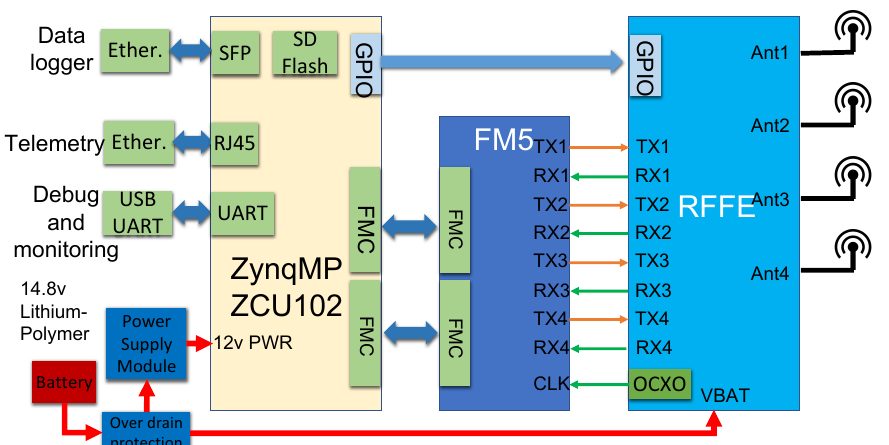
Figure 6. Block diagram of the hardware acrhitecture of the CHP2 prototype implementation. The system is driven by a ZynqMP ZCU102 evaluation kit, which interfaces with and ADI FMCOMMS5 RF evaluation board to produce RF signals, a transmit-receive switching and amplifier board to manage transmit and receive operations, and supporting hardware such as power supplies, data interfaces, and antennas.